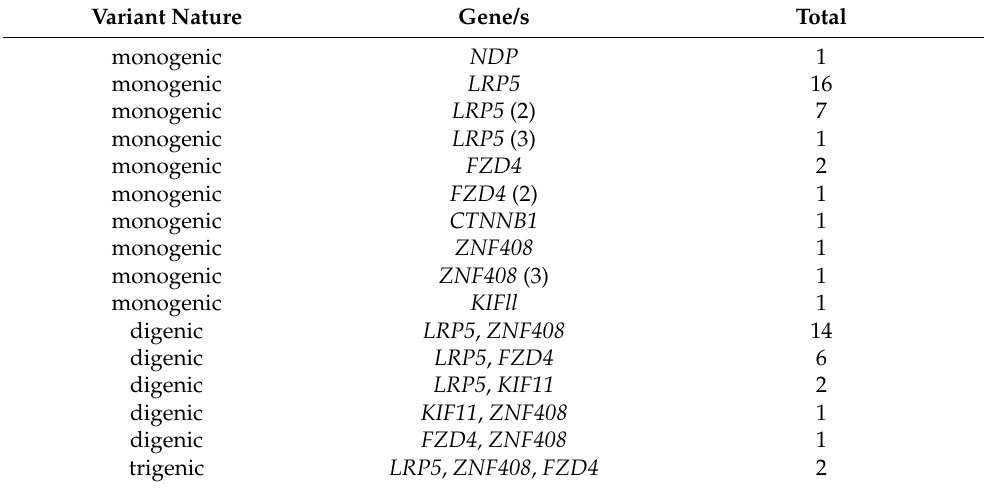
Table 5. Single and multigenic variants combinations. Protein-altering variants were found in multiple combinations in many patients. Multiple variants in single genes are indicated within parentheses. Totals are for the numbers of unique, different combinations detected. Genes are listed for the digenic and trigenic variant